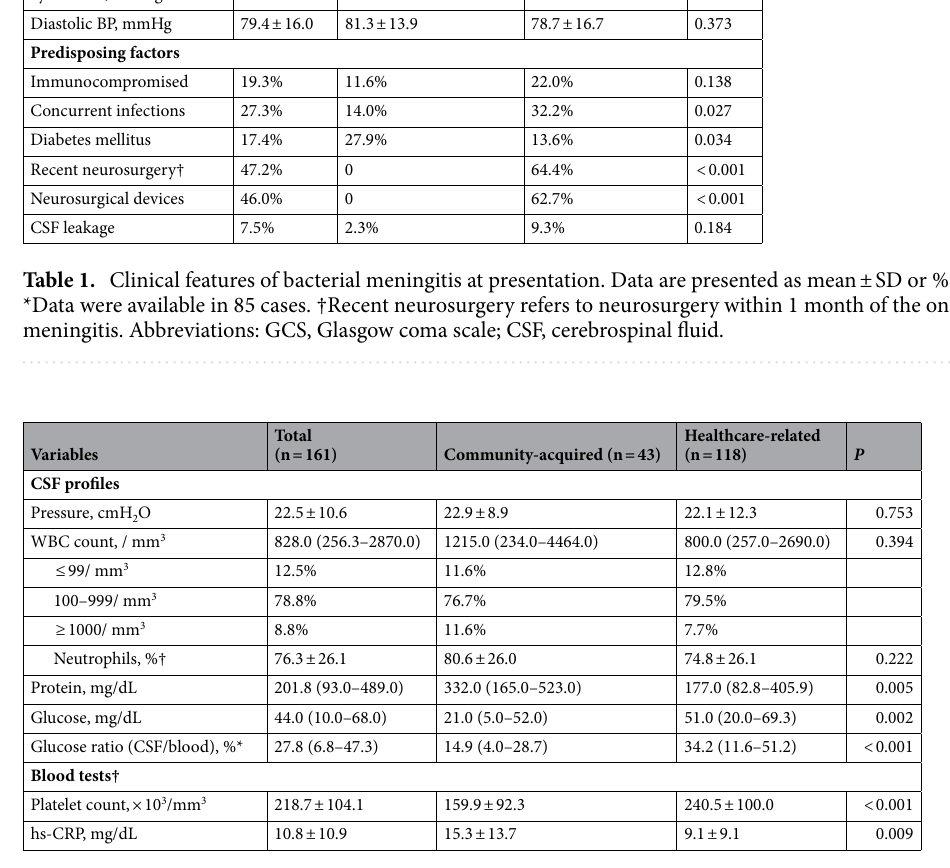
Table 2. Cerebrospinal fluid and blood test findings. Data are presented as mean ± SD, median (interquartile range), or %. *Data were available in 156cases. †Data were available in 159cases. Abbreviations: CSF, cerebrospinal fluid; WBC, white blood cell; hs-CRP, high-sensitivity C-reactive